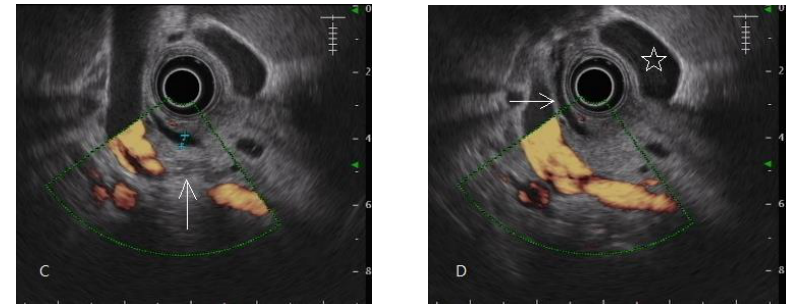
Figure 1. Endoscopic ultrasonography of a normal pancreas. The normal pancreatic parenchyma is homogeneous, and the main pancreatic duct edge is non-hyperechoic. ( A ) Pancreatic tail, body; spleen (star mark), splenic vessels. ( B ) Pancreatic body, neck, partial main pancreatic duct (arrow mark). ( C ) Pancreatic head, uncinate process (hypoechoic ventral part, arrow mark); gallbladder; partial main pancreatic duct. ( D ) Pancreatic head; gallbladder (star mark); main pancreatic duct (arrow mark).